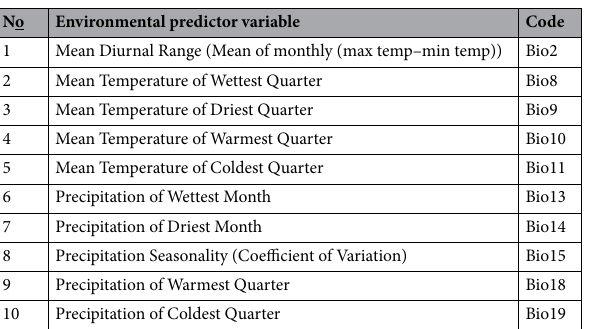
Table 1. The identified ten suitable bioclimatic variables which were used to generate the Erica distribution models.